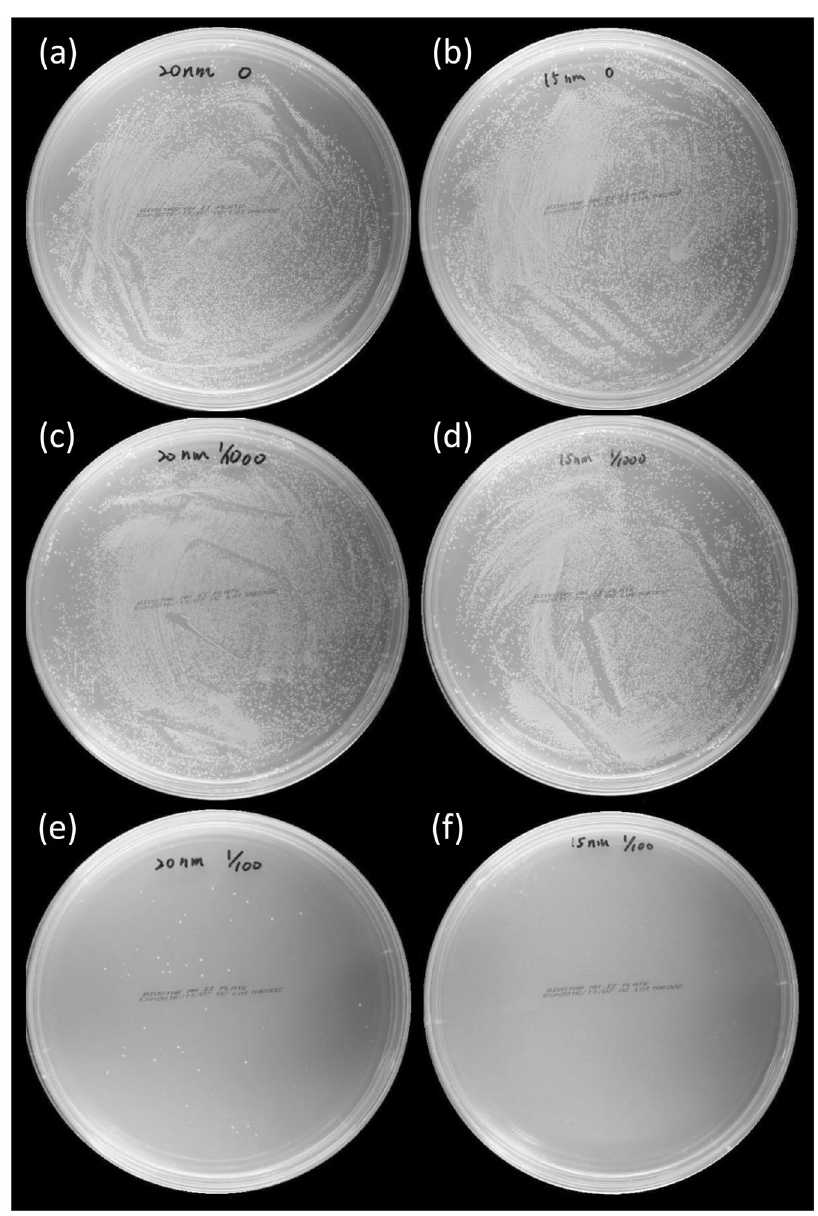
Figure 7. The antibacterial activity against E . coli on cellulose paper. The AATCC 100 antimicrobial fabric test was used to assess the antibacterial activity of the following NPs on cellulose paper, including ( a ) 20 nm Au NPs, ( b ) 15 nm Au NPs, ( c ) 20 nm Au-Ag 1000/1 NPs, ( d ) 15 nm Au-Ag 1000/1 NPs, ( e ) 20 nm Au-Ag 100/1 NPs, and ( f ) 15 nm Au-Ag 100/1